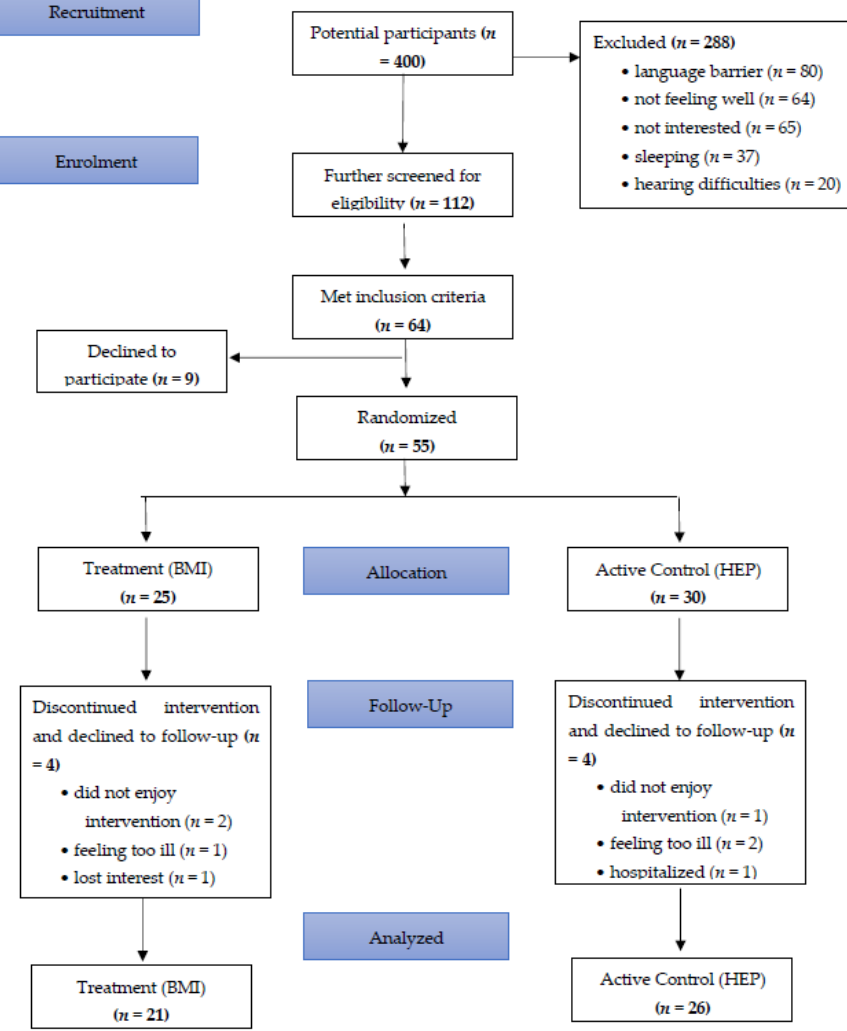
Figure 1. Participant flow diagram.